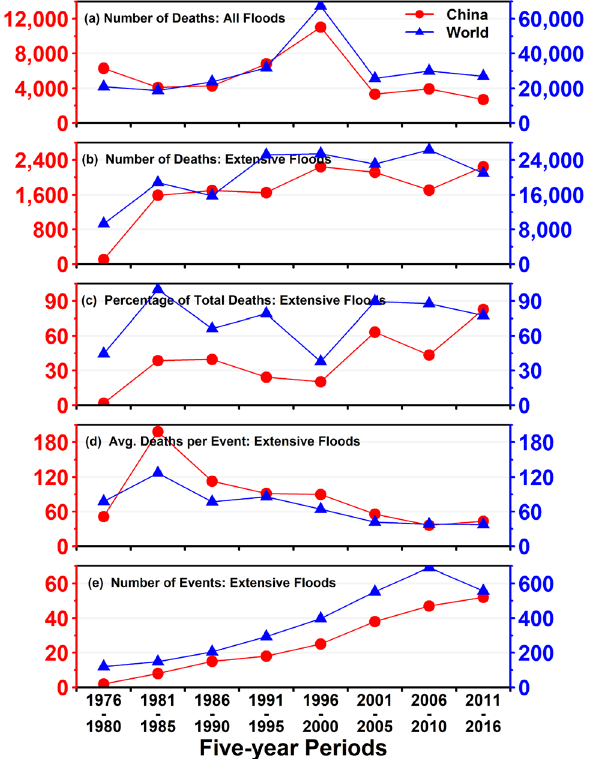
Fig. 5 Time series of ( a ) the number of total deaths from all floods; b the number of deaths from extensive floods; c the percentage of the total deaths from extensive flood loss events (that is, a return period of 2-years or shorter); d the average deaths per event from extensive floods; and e the number of extensive floods in China (solid dots) and across the globe (triangles) from the EM-DAT database (1976 to 2016). The lines connecting successive data points are for visual comparison and do not imply the full time series of